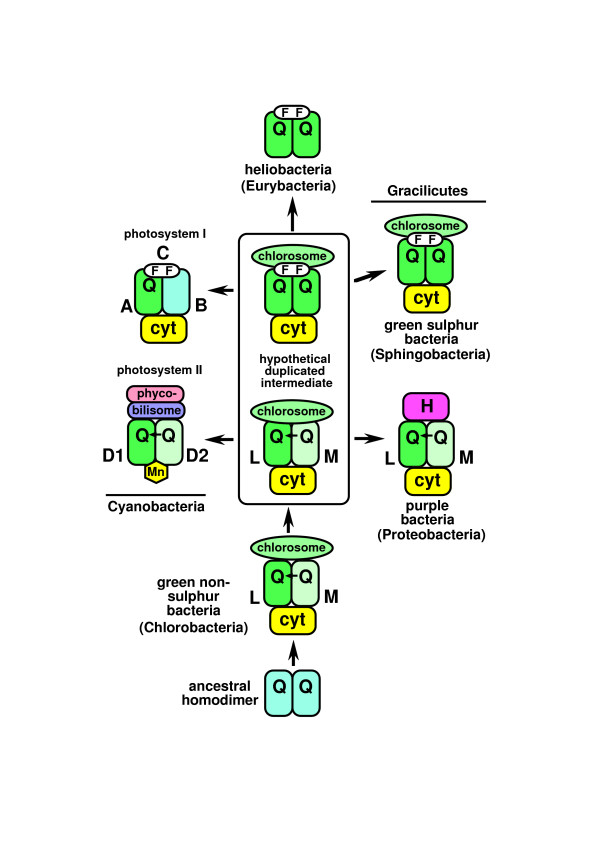
Hypothetical phylogeny for photosynthetic reaction centres. Prior to the last common ancestor of all extant life the primitive reaction centre, a homodimer with two bound quinones, each donating electrons to a primitive cytochrome cc complex, evolved into the heterodimeric type found in green non-sulphur bacteria (Chlorobacteria). This was duplicated prior to divergence of cyanobacteria and gracilicutes to generate a modified homodimeric type of cytochrome bc1 complex with iron-sulphur clusters (FF); for a mechanistic explanation of this duplication see [126]. Cyanobacteria converted the two versions into photosystems I and II. Proteobacteria replaced chlorosomes in the original heterodimeric type by an H subunit with purple carotenoid, but did not retain the new duplicate with FeS clusters. By contrast, this was the only version retained by green sulphur bacteria (Sphingobacteria) and Heliobacteria, both losing the earlier heterodimeric type. This scenario is simplified from ref. 1 and congruent with the cladistic tree in Fig. 7 and the concatenated rRNA tree [80] and is compatible with photosynthetic protein trees, if properly rooted (see text).